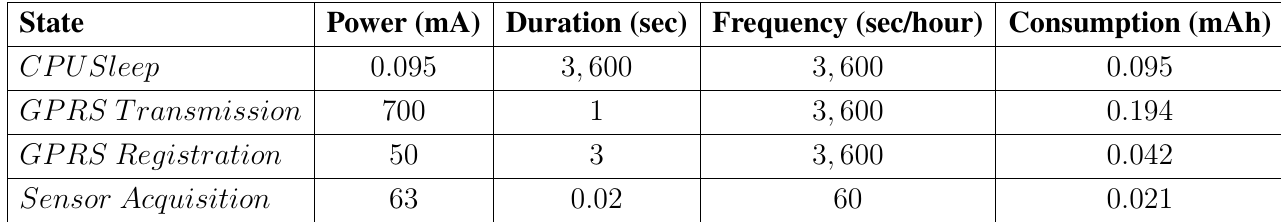
Table 2. Power consumption and duration of each periodical